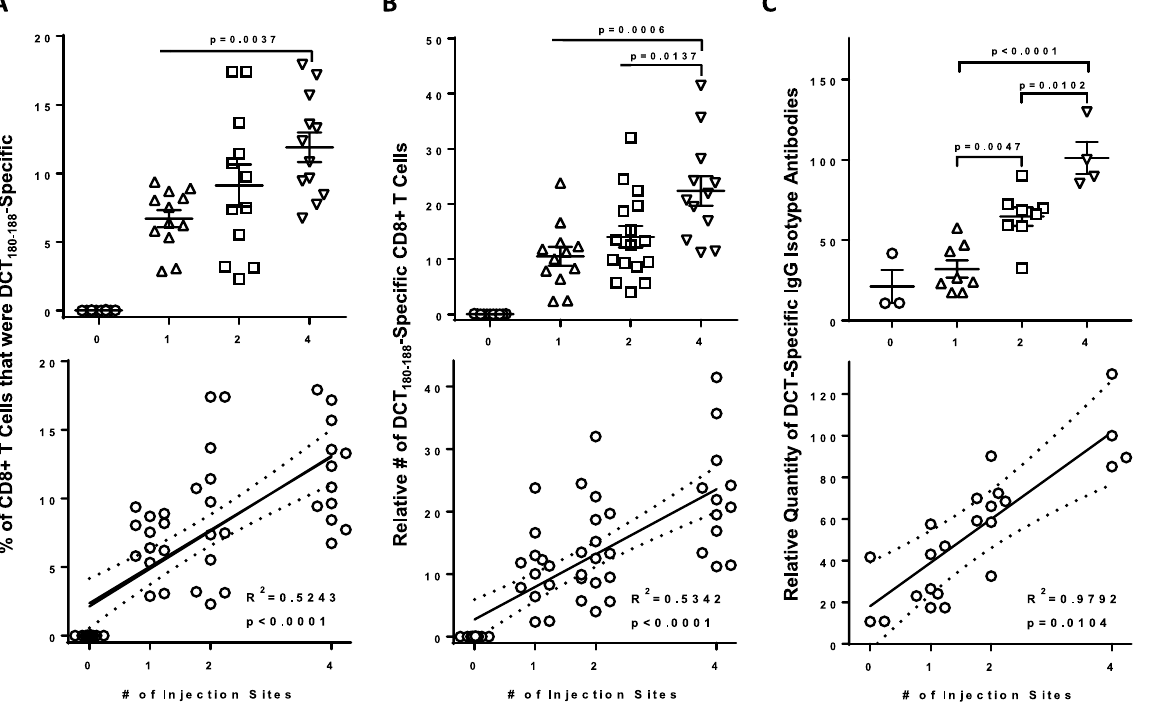
Figure 2. The magnitude of blood-derived antigen-specific CD8 + T cell and antibody responses correlated with the number of vaccine injection sites. Tumor-free female C57BL/6 mice were vaccinated intramuscularly with 1 × 10 8 pfu of recombinant human serotype 5 adenovirus expressing the melanoma-associated antigen dopachrome tautomerase, with injections spread across one (semitendinosus; left hind limb), two (semitendinosus of both hind limbs) or four (semitendinosus of both hind limbs and the triceps brachii of both forelimbs) sites. ( A , B ) Blood-derived CD8 + T cells specific for the immunodomiant self-epitope DCT 180–188 were quantified fourteen days post-vaccination by flow cytometric assessment of intracellular cytokine staining after ex vivo re-stimulation with peptides. One-way analysis of variance with Tukey’s multiple comparison test (upper panels) and Pearson correlation analysis (lower panels) was performed for the ( A ) frequency and ( B ) total number of antigen-specific CD8 + T cells ( n = 12–16/treatment; pooled from three experimental replicates). ( C ) Plasma-derived antibodies (IgG) specific for dopachrome tautomerase were quantified thirty- three days post-vaccination using an in-cell western blotting assay and assessed by one-way analysis of variance (upper panel) and Pearson correlation analysis (lower panel; n = 3 controls and 4–8/treatment; pooled from two experimental replicates). Correlation analyses show lines of best fit with 95% confidence